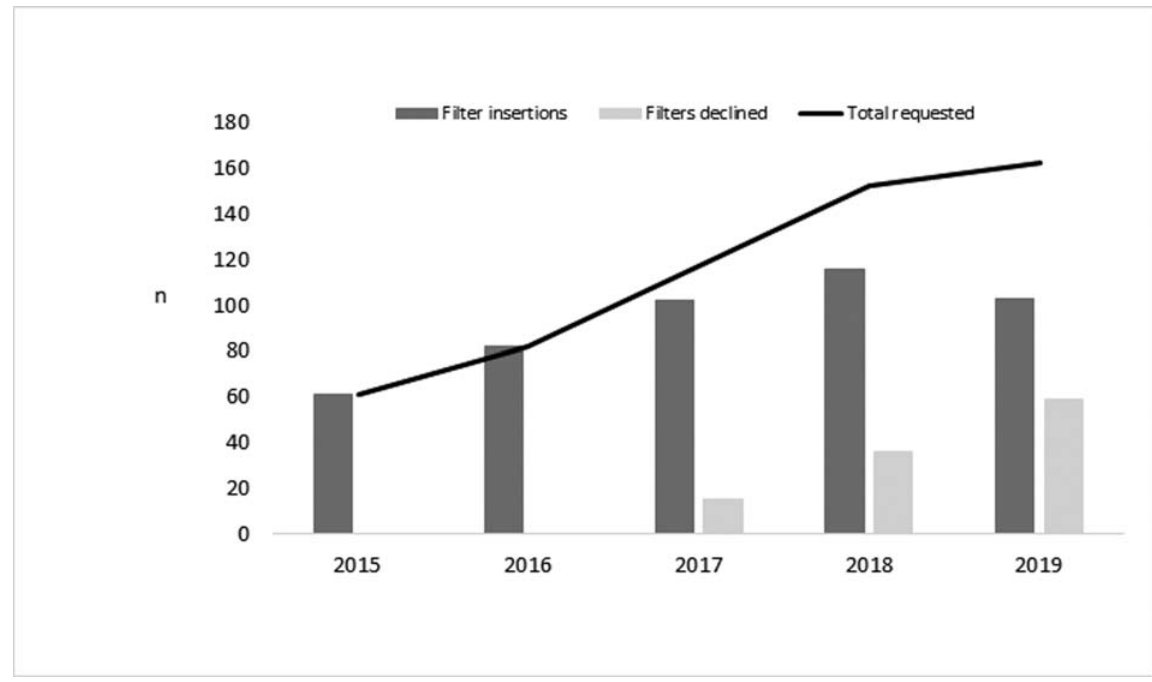
Fig. 1 Number of IVC fi lters requested, inserted and declined 2015 to 2019. IVC, inferior vena